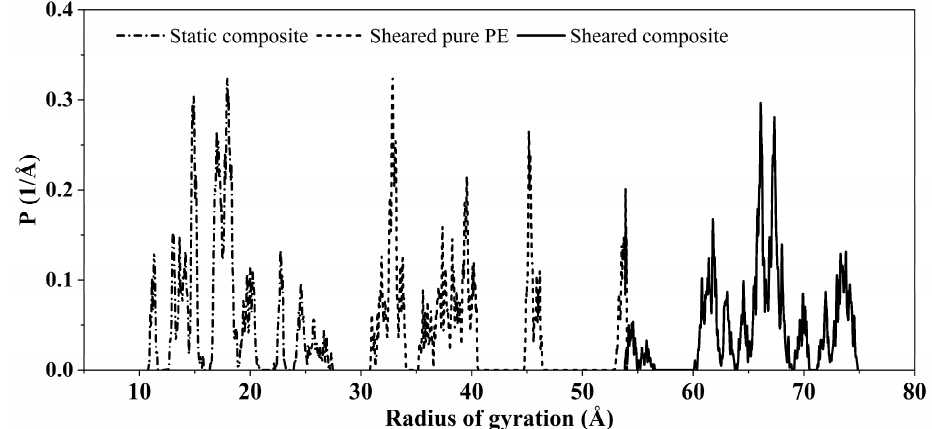
Figure 2. The distribution curve of the radius of gyration of PE molecular chains after running for 500 ps.